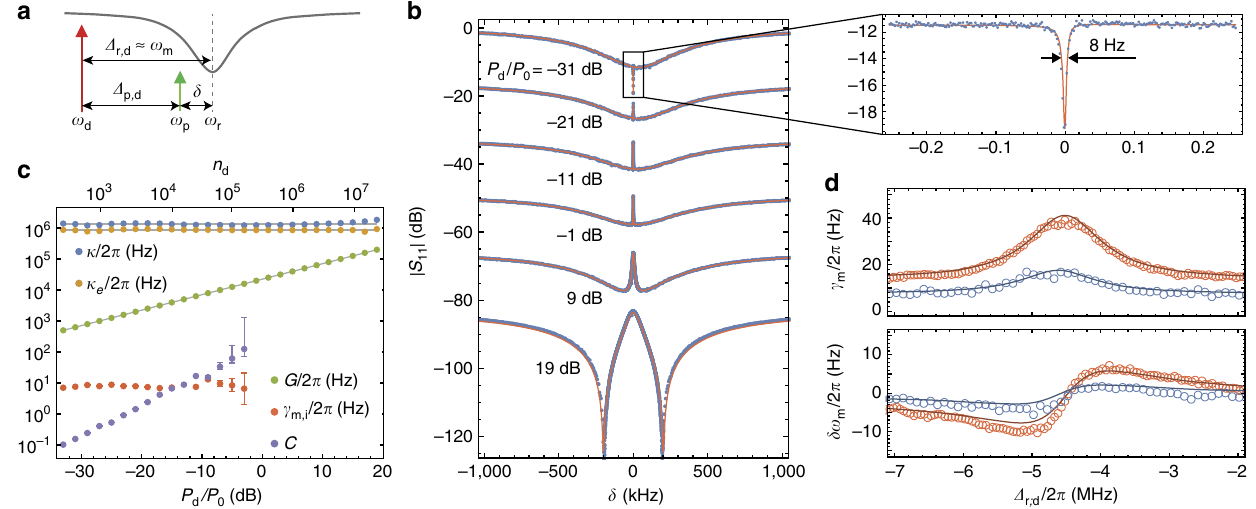
Figure 3 | Coherent response. ( a ) Schematic of the two-tone electromagnetically induced transparency (EIT) spectroscopy measurement. ( b ) Measured (blue points) probe spectra for different drive powers ( P 0 ¼ 1mW), all with a fixed drive detuning of D r,d ¼ o m ¼ 4.815MHz. Each spectrum is offset by (cid:3) 16.5dB for better visibility. Fits to measured spectra using equation (2) are shown as solid red curves. Inset shows a zoomed-in view of the lowest power measurement with a mechanical linewidth of g m /2 p ¼ 8Hz. ( c ) Extracted system parameters (symbols) as a function of drive power using equation (2) to fit the measured spectra ( P 0 ¼ 1mW). Error bars correspond to a 95% confidence interval in the fit to the measured spectra. ( d ) Mechanical linewidth g m (top) and the mechanical frequency shift do m due to the optical spring effect (bottom) versus drive detuning D r,d at a fixed intra-cavity drive photon number. Shown are the fit values from the measured probe spectra for two different fridge temperatures, T f ¼ 11mK (blue circles) and T f ¼ 114mK (red circles). The drive photon number at T f ¼ 11mK ( T f ¼ 114mK) is equal to n d ¼ 2,350 (5,980). The solid line curves are a fit to the damping and spring shift using a radiation pressure back-action model as per ref.